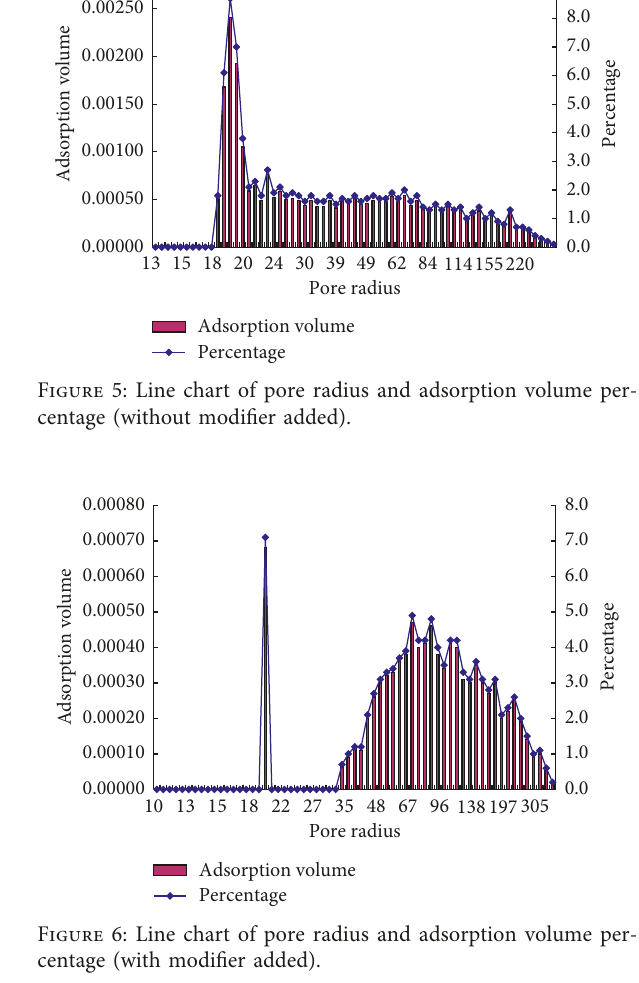
Table 5: Statistical table of measurement results of surface tension and contact angle.